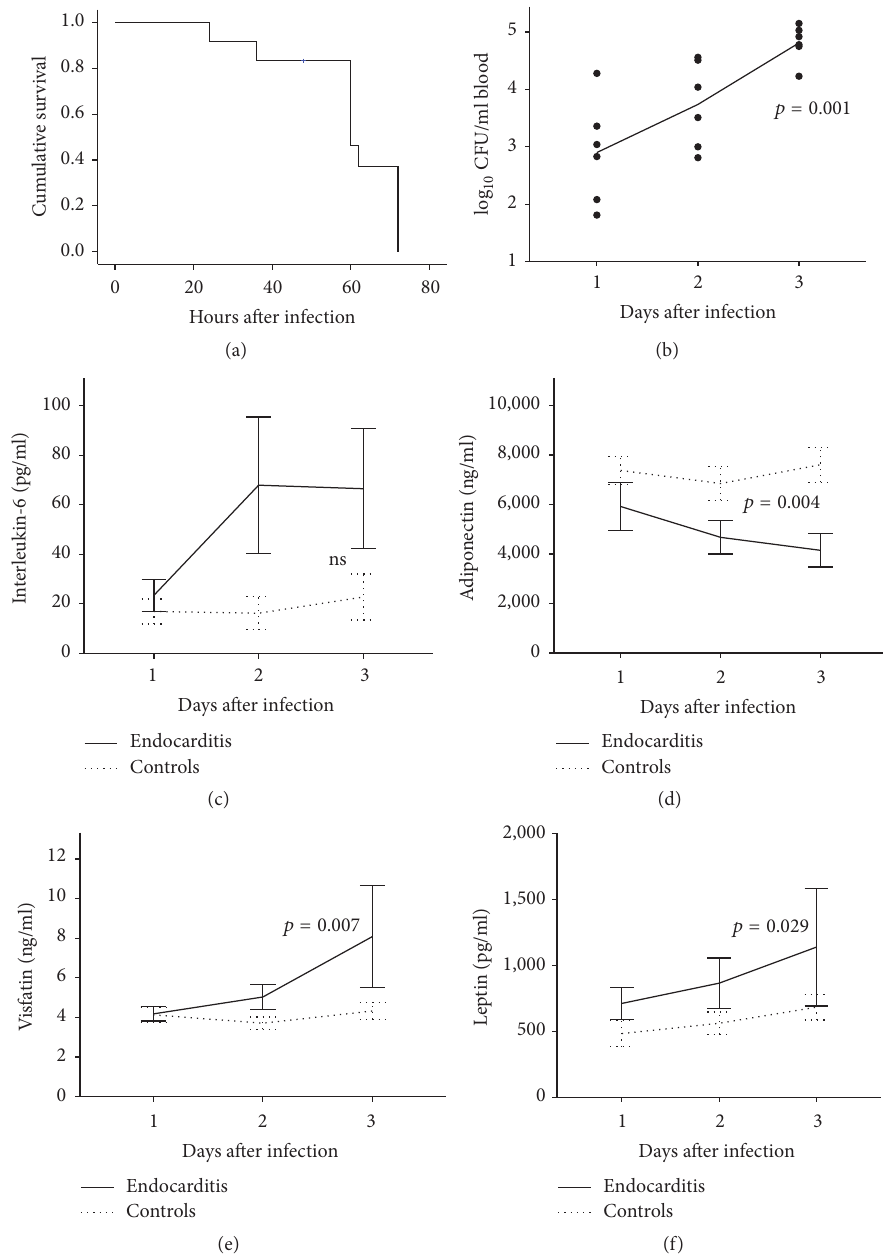
Figure 1: Natural course of fatal S. aureus endocarditis and serum adipokine concentrations in an experimental rat model. Serum and whole bloodwerecollectedfromrats( 𝑛 =5–7pertimepoint)sufferingfromanultimatelyfatal S.aureus endocarditis.Serumcytokineandadipokine levels were measured by ELISA in duplicate. (a) Cumulative survival of animals during the natural disease course. Cumulative survival is given in percent (%) during the time after infection given in hours (h). (b) Bacteremia during the natural disease course. Colony forming units are given in units/mL blood by using a logarithmic scale and were documented at day 1, day 2, and day 3 after infection. Bacteremia increased significantly ( 𝑝 = 0.001 , one-way ANOVA) over time. (c) Time course of serum IL-6 concentrations in infected (black line) and noninfected control (spotted line) animals. IL-6 concentrations were increased in S. aureus infected rats; however, this trend did not reach significance (ns, not significant). (d) Time course of serum adiponectin concentrations in infected (black line) and noninfected control (spotted line) animals. Adiponectin concentrations were significantly ( 𝑝 = 0.004 , two-way ANOVA) lower in rats with S. aureus endocarditis than in uninfected control animals. (e) Time course of serum visfatin concentrations in infected (black line) and noninfected control (spotted line) animals. Visfatin concentrations were significantly higher in S. aureus infected animals ( 𝑝 = 0.007 , two-way ANOVA). (f) Time course of serum leptin concentrations in infected (black line) and noninfected control (spotted line) animals. Leptin concentrations were significantly higher in S. aureus infected animals ( 𝑝 = 0.029 , two-way